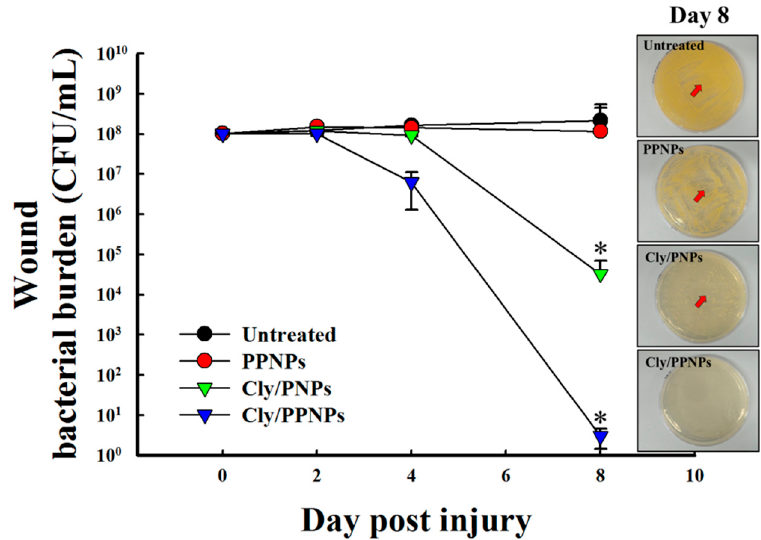
Figure 7. Viable counts of bacteria on wounds. Wounds were swabbed, and bacterial burden was examined. Inset shows the bacterial growth after plating of swab samples on tryptic soy broth (TSB) agar at day 8 post injury.